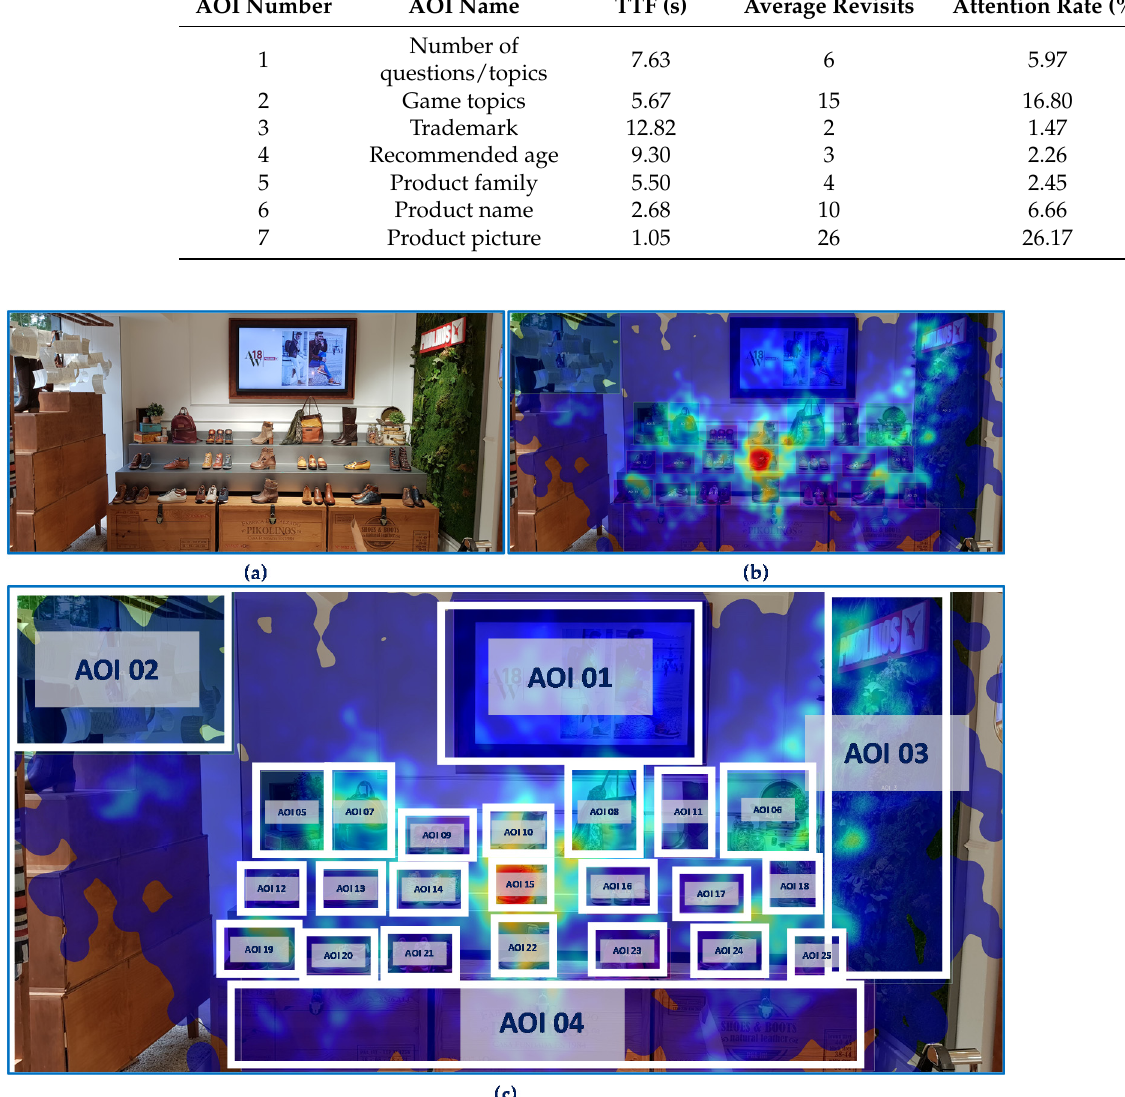
Table 4. Toy packaging. Time to First Fixation (TTF) and attention percentage of the total number of participants to each